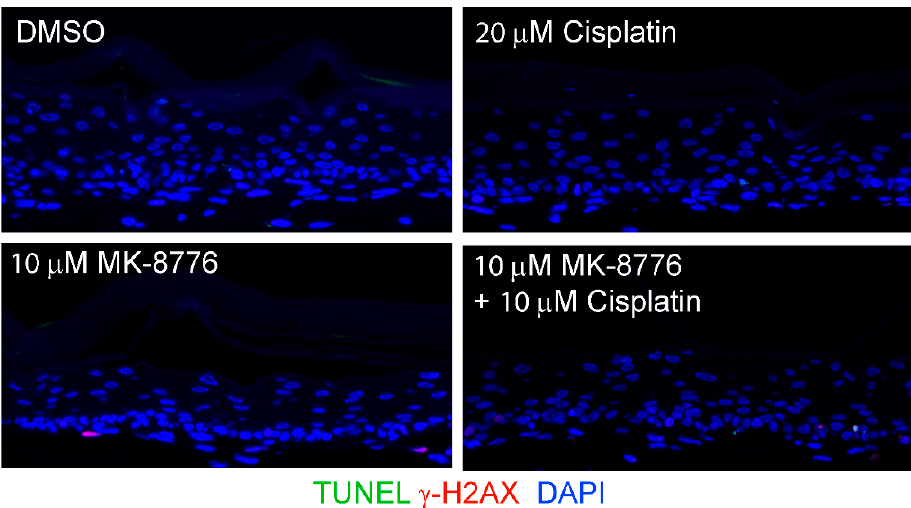
Figure 9. Combination of cisplatin and MK-8776 is weakly toxic on uninfected PHK raft cultures. TUNEL assay and γ -H2AX was probed in raft cultures of uninfected PHKs exposed to DMSO, 20 µM cisplatin, 10 µM MK-8776 and combination of cisplatin and MK-8776, both at 10 µM, from days 9 to 12 before harvest. Images were captured with 20 × objective. Note that the epithelium was thinner in all three treatments attributed to a blockade of basal cell proliferation. However, there is hardly any γ -H2AX induction or TUNEL signals.